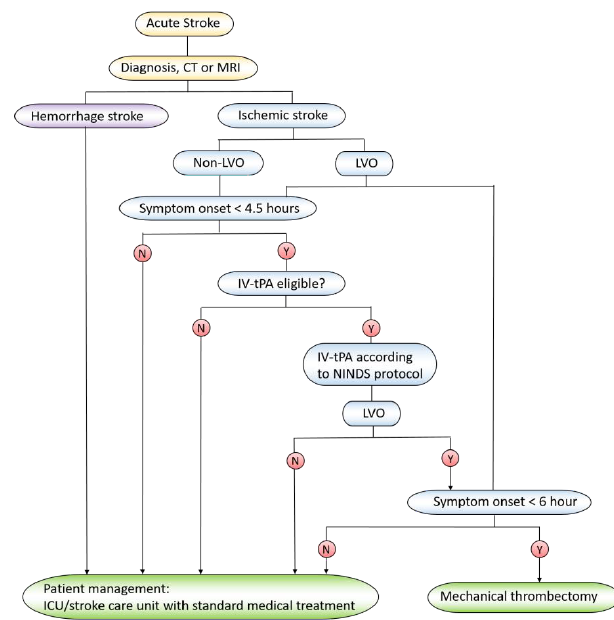
Figure 2. The procedure to treat stroke patients. CT: computed tomography; MRI: magnetic resonance imaging; LVO: large vessel occlusion; IV-tPA: intravenous injection of trans-plasminogen activator; ICU: intensive care unit; NIHSS: National Institutes of Health Stroke Scale; Y: yes; N: no.